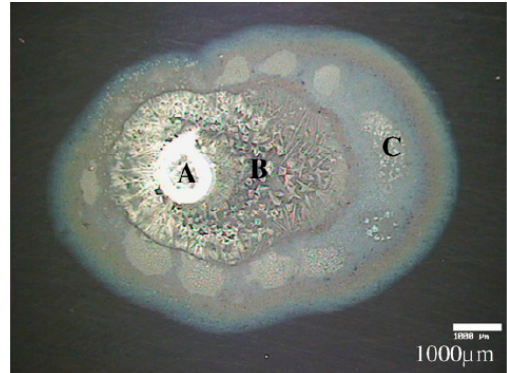
Figure 7. An optical image of a zinc surface with a deposited NaCl particle exposed to 90% RH for 6 h. The corrosion products identified in the three points A, B, and C are discussed in the text. Reprinted from reference [67] with permission from Elsevier. Copyright 2008.